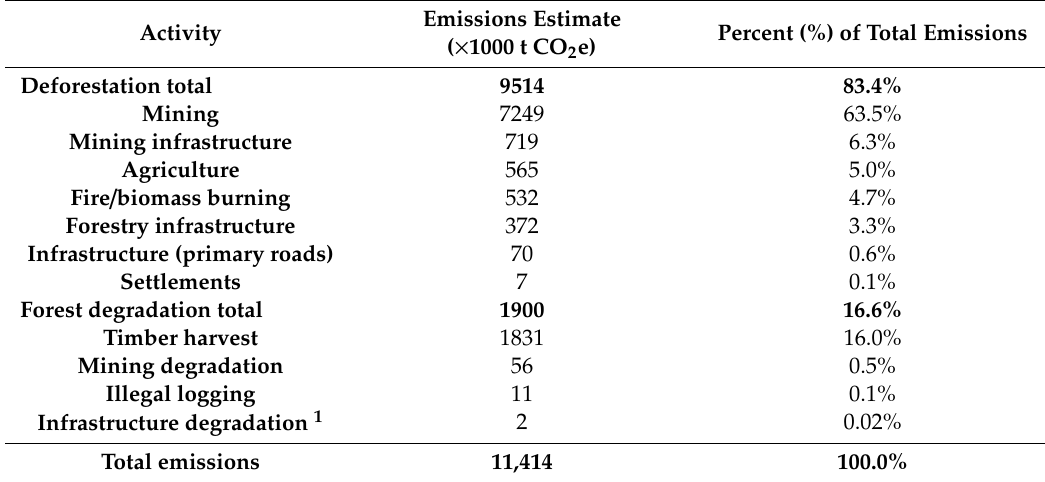
Table 1. 2018 emission estimates for all sources under Guyana’s REDD +